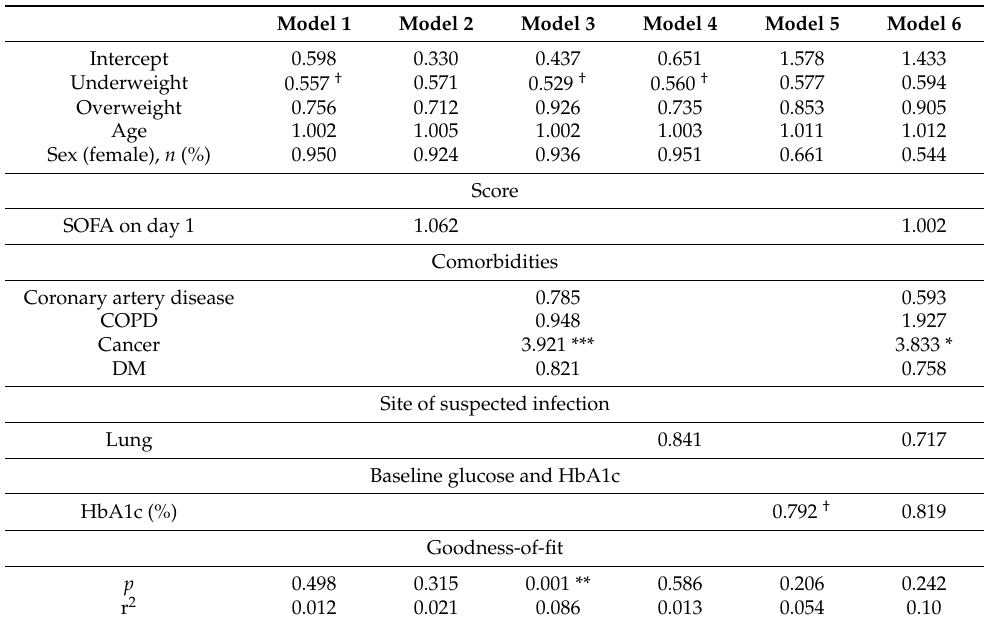
Table 4. Results (odds ratios) of the logistic regression analysis of risk factors for 90-day mortality in patients with sepsis who had low modified NUTRIC